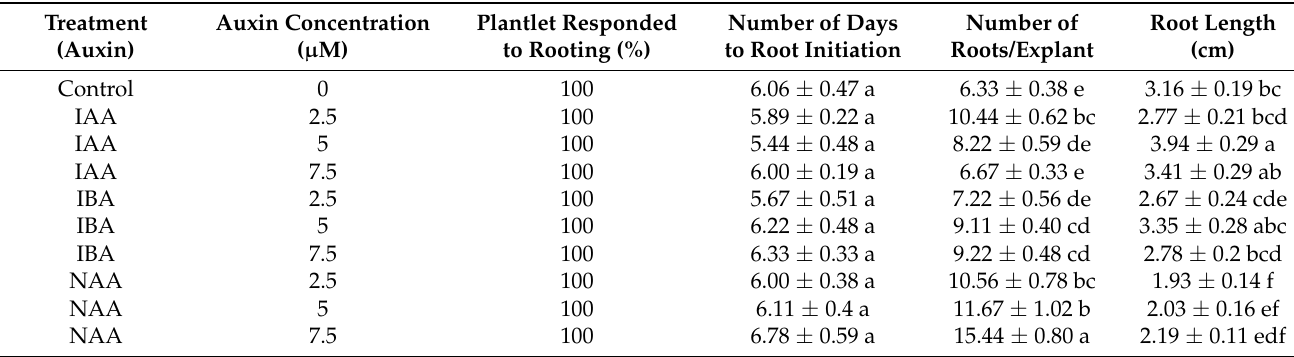
Table 5. Effect of different types and concentrations of auxin on rooting of in vitro-raised shoot of ’Bentong’ ginger after four weeks of the